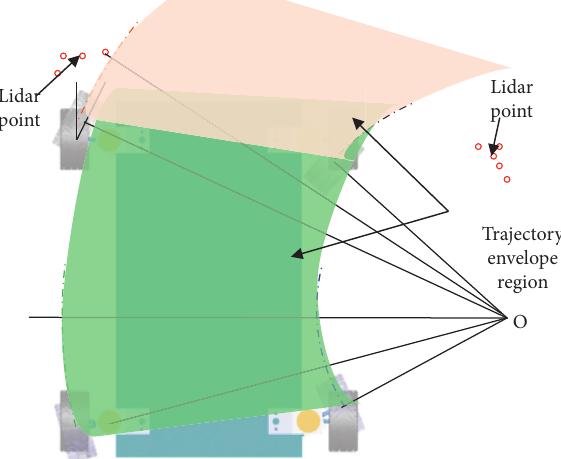
Figure 9: Obstacle avoidance geometric relation analysis diagram. (a) The gap has two end points, P point P m .